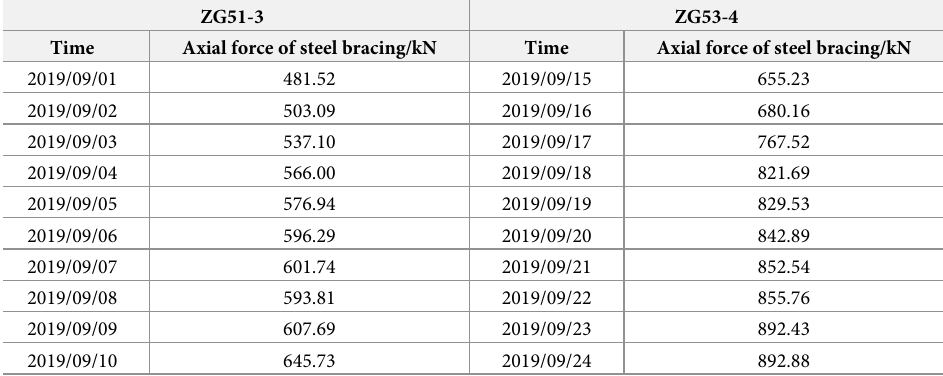
Table 2. Axial force data of steel bracing for 10 days.